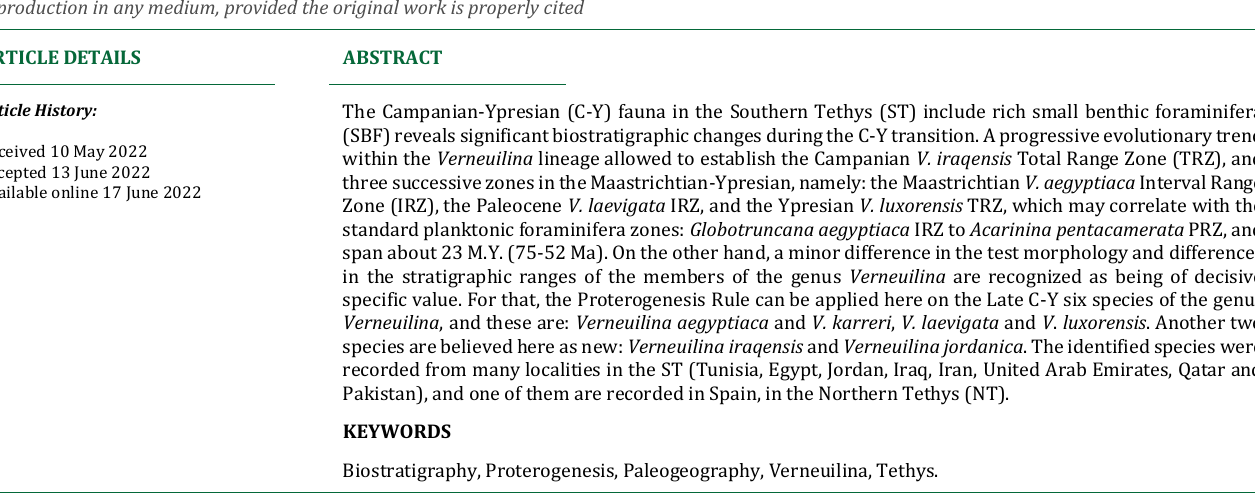
2. V ERNEUILINA B IOZONATION IN T HE ST Verneuilina species provide one of the most highly resolved biostratigraphic subdivisions of C-Y. A total of six specimens of Verneuilina have been identified from many localities in ST. The identified species, its dimensions of the test, and the acuteness of the periphery are shown in Plate 1. The stratigraphic levels of the recorded Verneuilina members in this study, the proposed local biostratigraphic biozones are presented in Figure 2. Three species were recorded in the Late Cretaceous (Campanian- Maastrichtian): V. iraqensis n. sp. (Iraq), V. aegyptiaca and V. karreri (Egypt), while the other three species are from the Early Paleogene (Paleocene-Ypresian): V. laevigata from Paleocene (Pakistan), V. jordanica from Paleocene-Ypresian (Jordan), and V. luxorensis also from Ypresian (Egypt and Spain) (Haque, 1956; Nakkady, 1950; Said and Kenawy, 1956). The proposed local biozonation of the members of Verneuilina can be presented in the